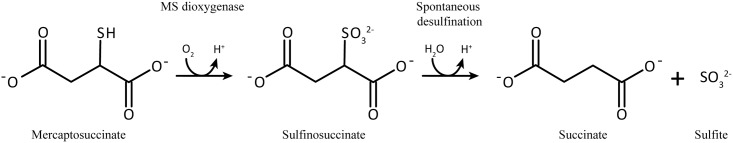
Degradation of 2-mercaptosuccinate in Variovorax paradoxus B4 [23].